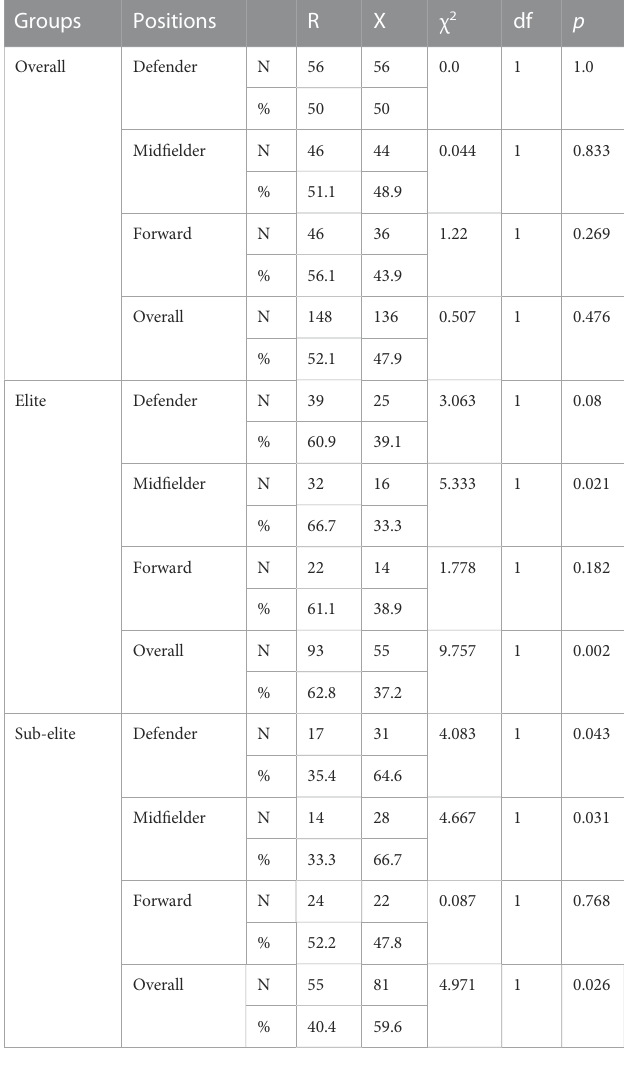
Tables 2, 3 summarizes the distribution of ACTN3 genotypes and allele frequencies in elite and sub-elite players at different positions. Genotype RX (39.4%) was the most common among all players. Genotype RR (44.6%) was the most common in elite players, and RX